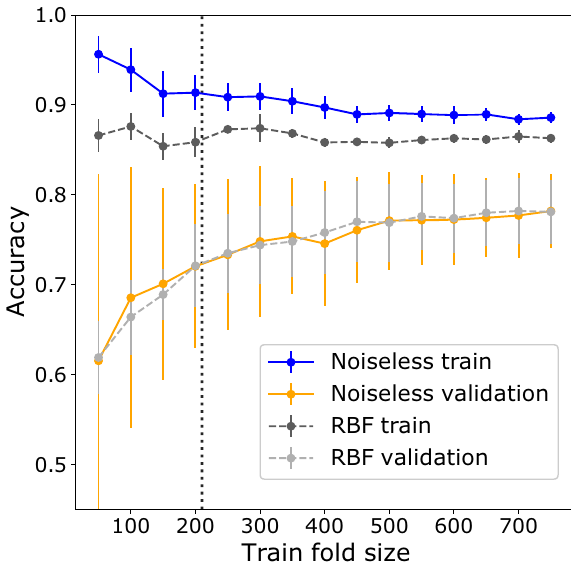
Fig. 3 Learning curve and sample variance. Learning curve for an SVM trained using noiseless circuit encoding on 17 qubits vs. RBF kernel k ð x i ; x j Þ ¼ exp ð(cid:3) γ jj x i (cid:3) x j jj 2 Þ with γ = 0.012 optimized via adaptive grid search over [10 − 5 , 10 − 1 ]. Points re fl ect train/test accuracy for a classi fi er trained on a strati fi ed 10-fold split resulting in a size- x balanced subset of preprocessed supernova data points. Error bars indicate standard deviation over 10 trials of down- sampling, and the dashed line indicates the size m = 210 of the training set chosen for this